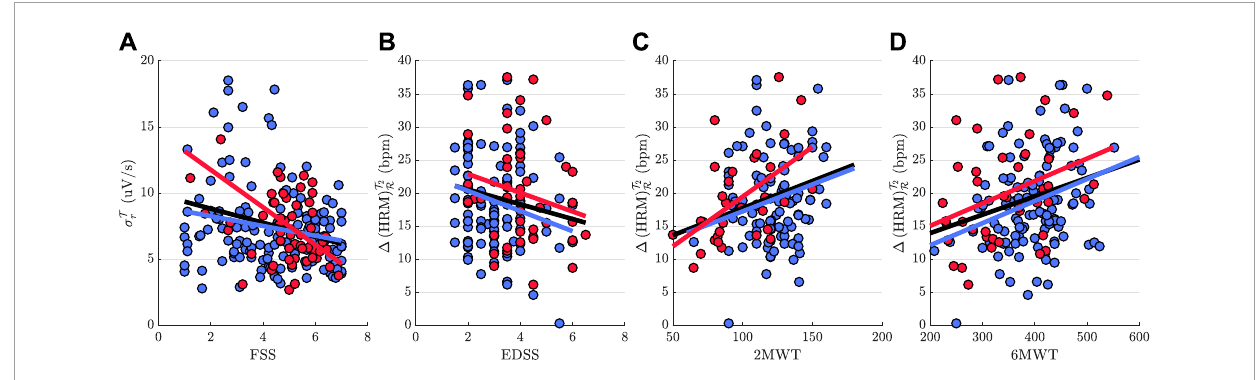
( Figure 2O ). Sympathetic dominance was statistically significant higher in 6MWT group during recovery period ( Figure 2N H